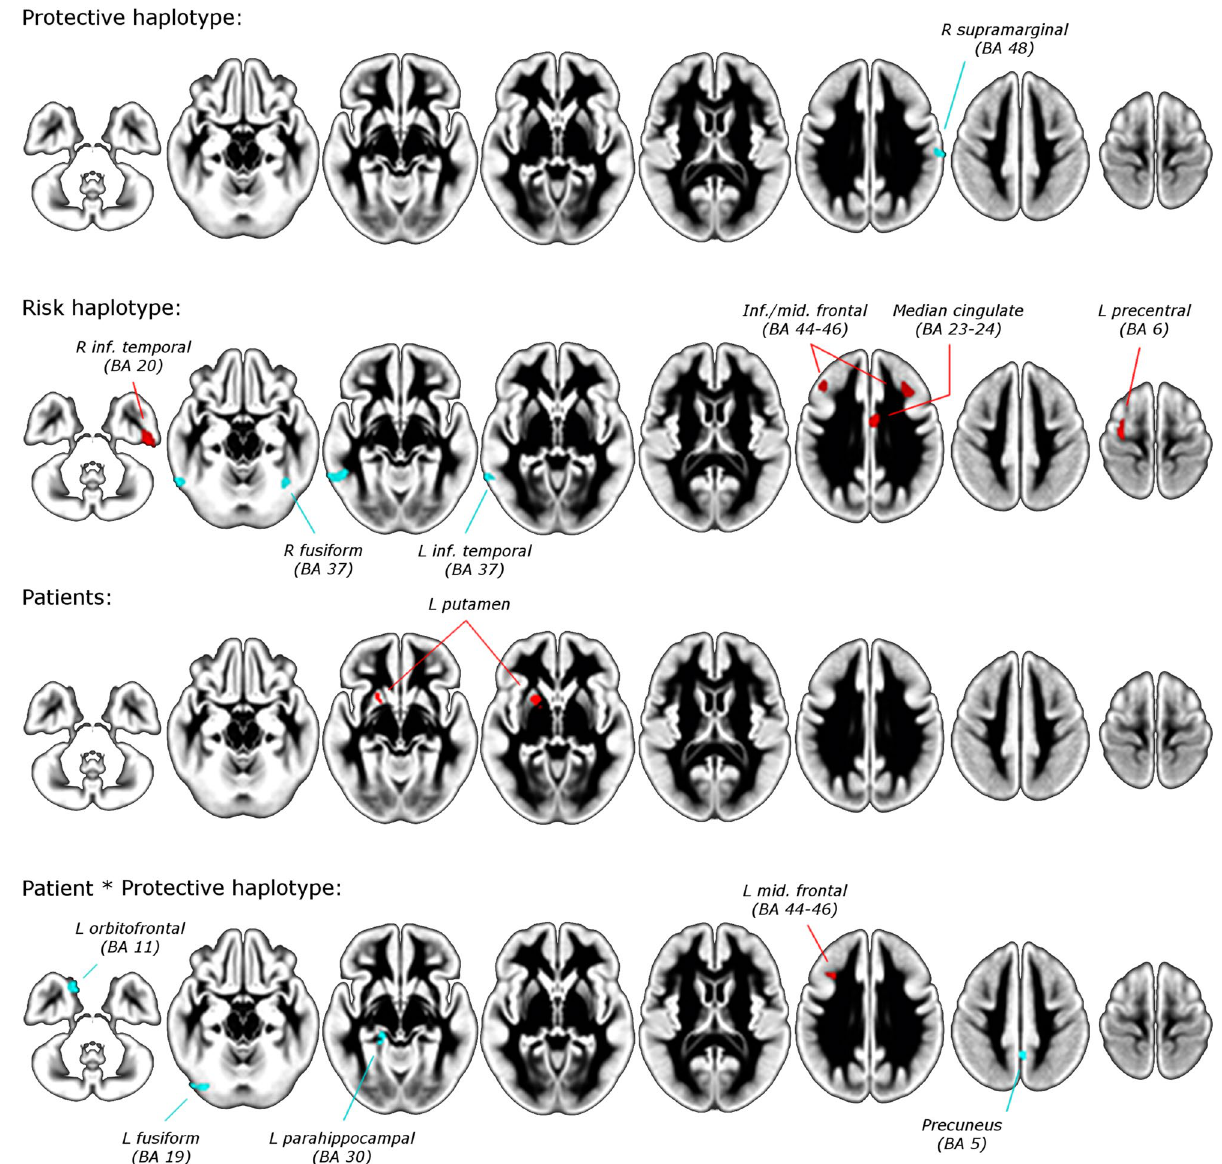
in patients with ADHD relative to healthy subjects. Bottom: Volumetric interaction between ADHD status and protective haplotype. Areas in red indicate significantly more gray matter in individuals with the haplotype or patients or a positive interaction between the disorder and the haplotype; blue areas indicate substantially less gray matter in individuals with the haplotype or negative interaction between the disorder and the haplotype. Differences were not statistically significant after correction for multiple